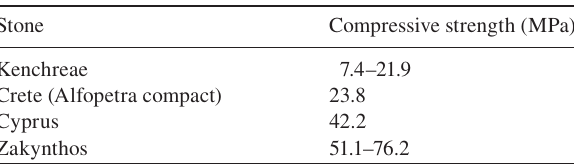
Table 1 Peak stress of the authentic and substitute materials as obtained from commercial